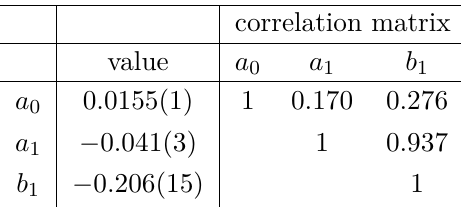
Table 5 . Values of BGL parameters extracted from fitting the BGL parameterization against LCSR and lattice QCD predictions. Correlations between the three parameters are also